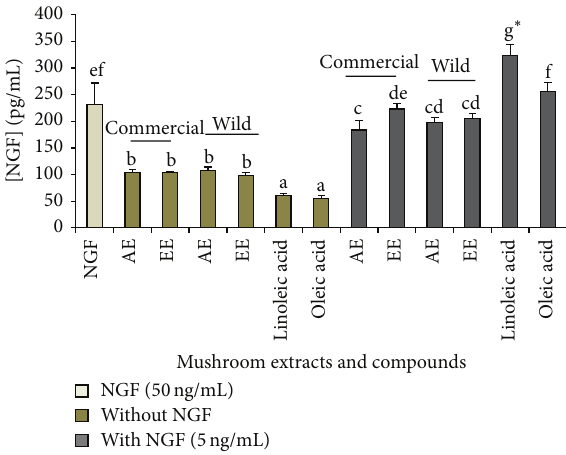
Figure 2: The effects of mushroom aqueous and ethanol extracts on the stimulation of NGF secretion by neurite-bearing PC12 cells in the presence or absence of NGF. NGF (50ng/mL) was used as the positive control. Values are mean ± SD from three indepen- dent experiments. Different letters represent significant differences between samples ( 𝑃 < 0.05 ). ∗ 𝑃 < 0.05 represents a significant difference from the control, that is, 50ng/mL of